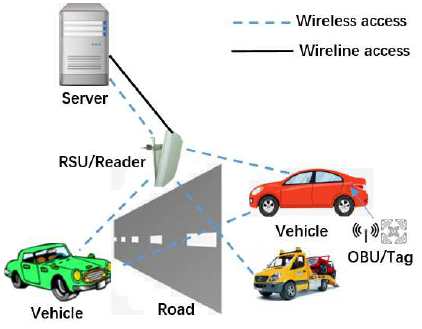
Figure 1. RFID-based architecture for transportation